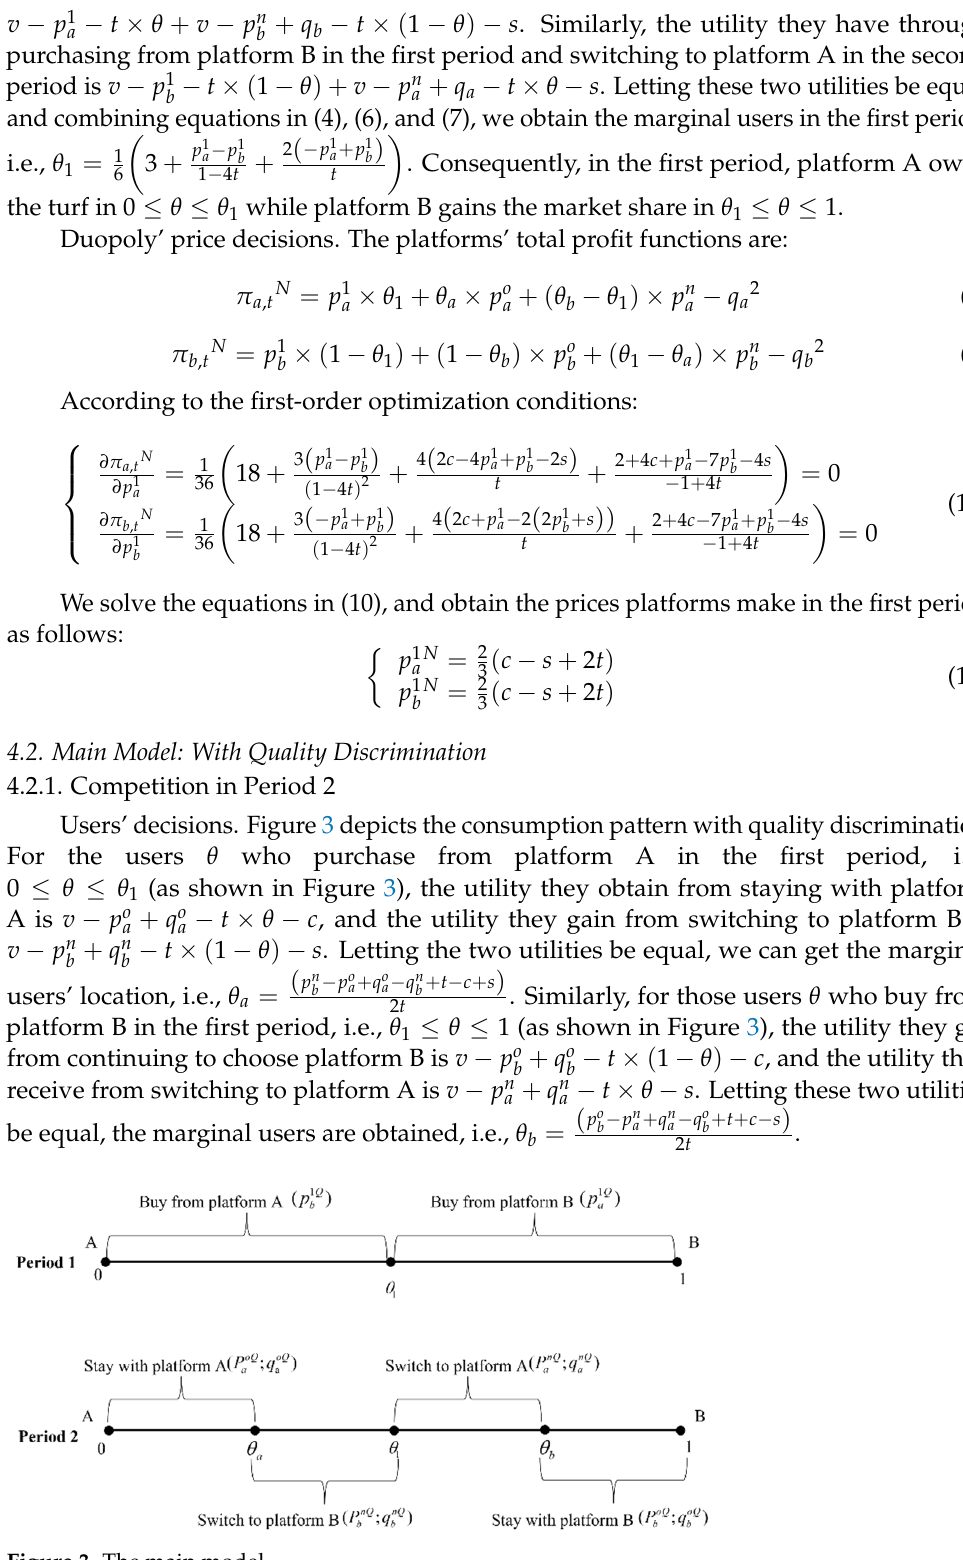
Figure 3. The main model.